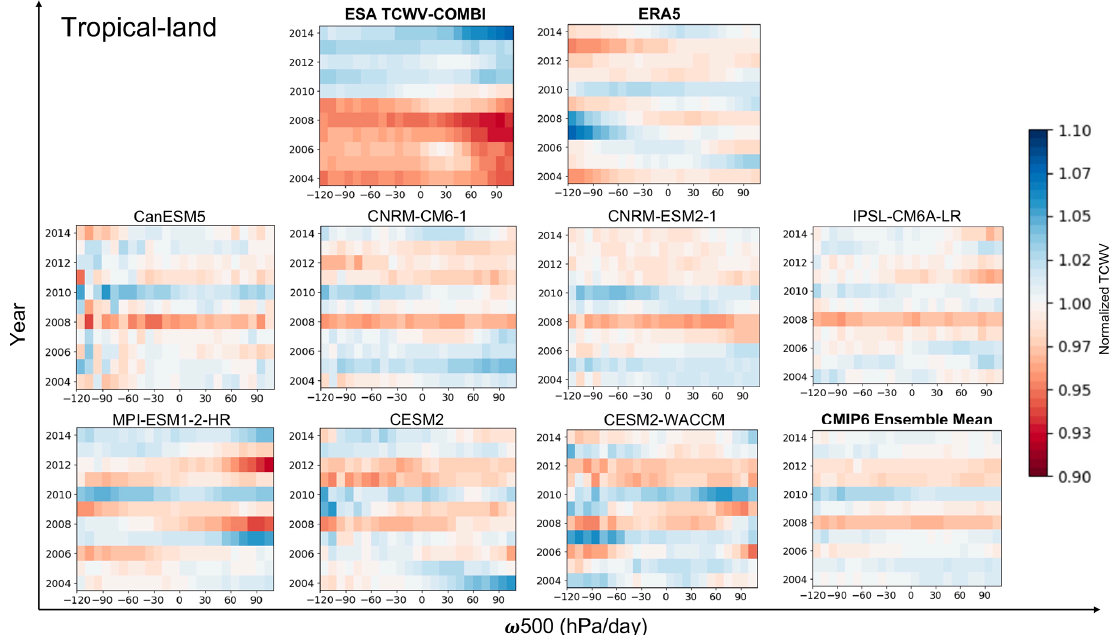
Figure 9. Normalized TCWV with respect to the 2004–2014 mean over tropical-land areas at each dynamical interval ( ω 500) in 10hPad − 1 computed from each data